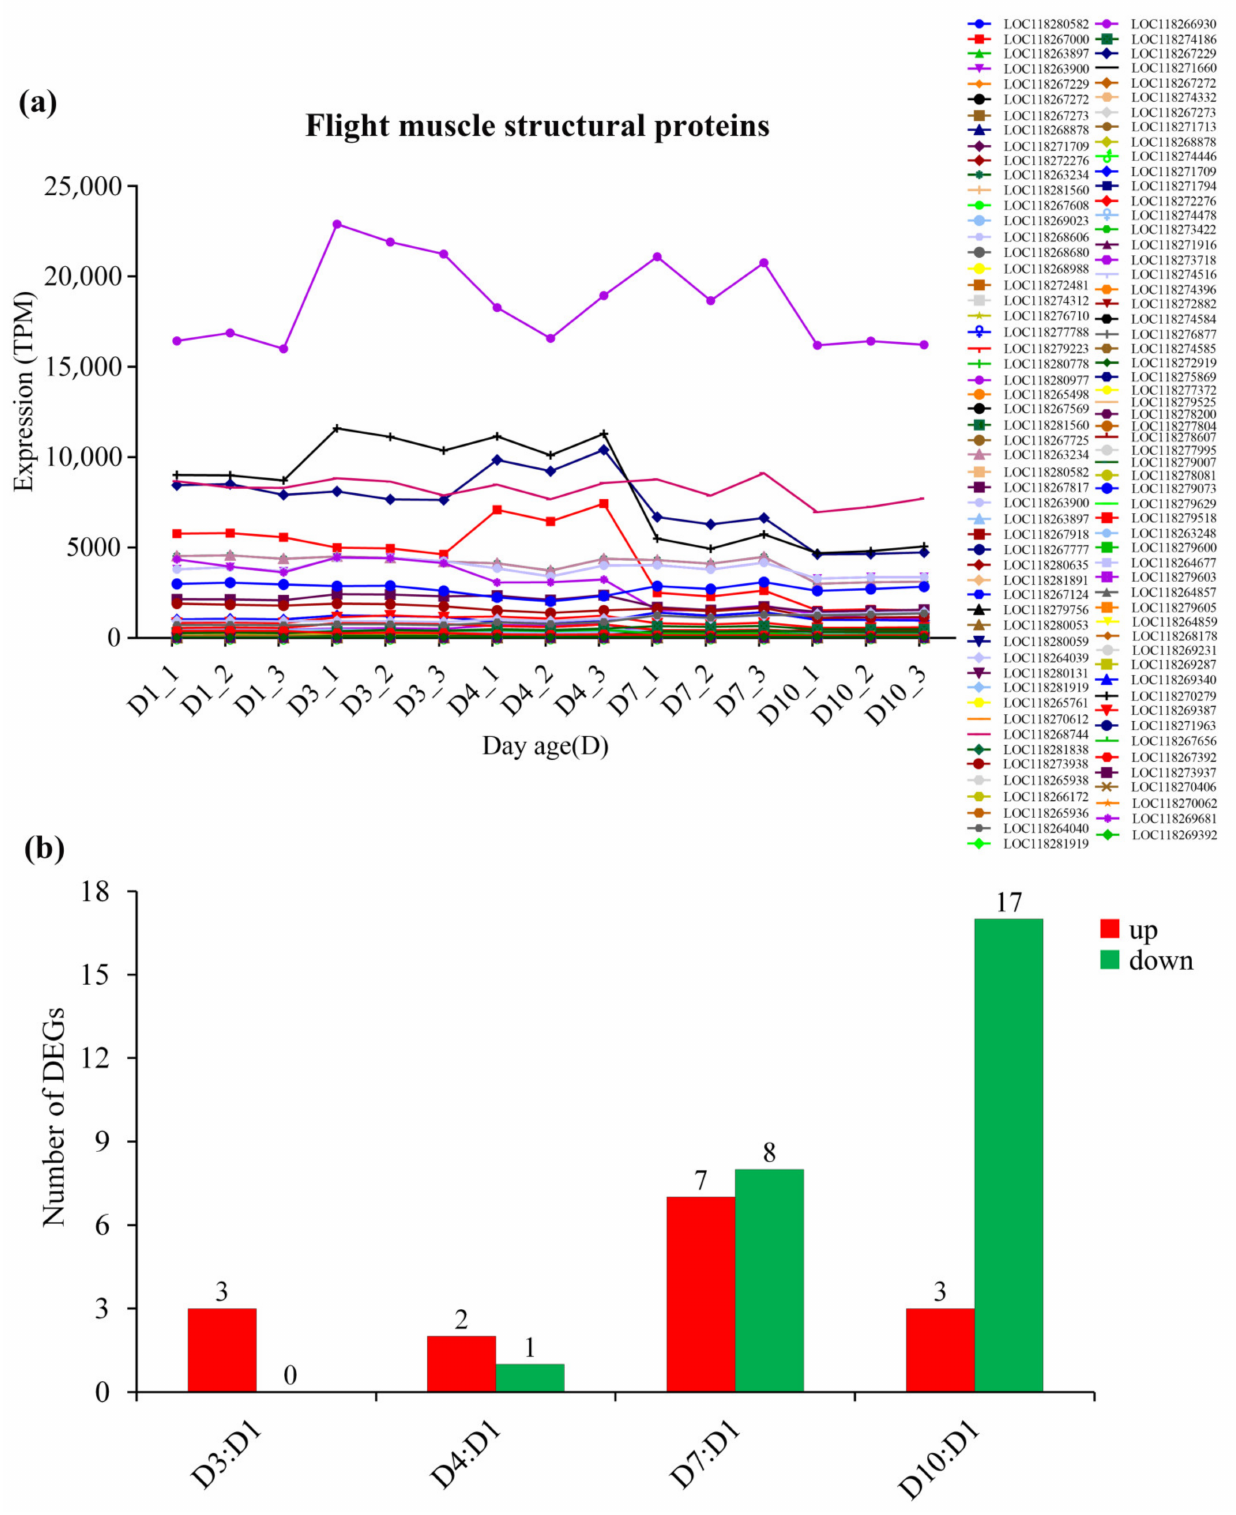
Figure 9. The expression of flight muscle structural proteins in S. frugiperda females at different ages. ( a ) Changes in gene expression with age; ( b ) DEGs of D3:D1, D4:D1, D7:D1 and D10:D1 groups, wherein red columns represent upregulated DEGs and green columns represent downregulated